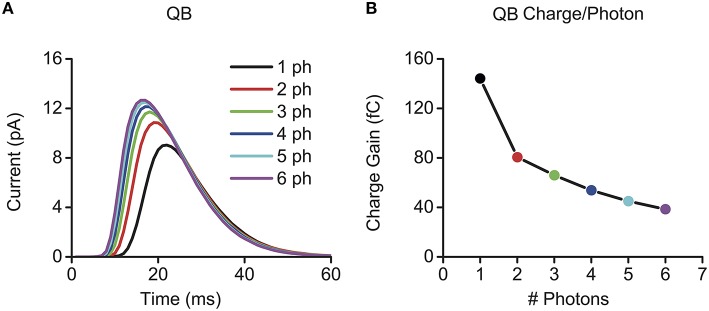
Quantum-gain-nonlinearity induced by sublinear bump summation in multi-photon elicited QBs. Here, quantum-gain-nonlinearity is illustrated through multi-photon evoked QBs, which were calculated by using the full Drosophila photoreceptor model, see Song et al. (2012). (A) Bigger QBs are evoked by multi-photon-hits. (B) The quantum gain (QB charge/photons) decreases nonlinearly. QB charge was calculated by integrating QB waveform in (A), and its unit is fC (femto coulomb).